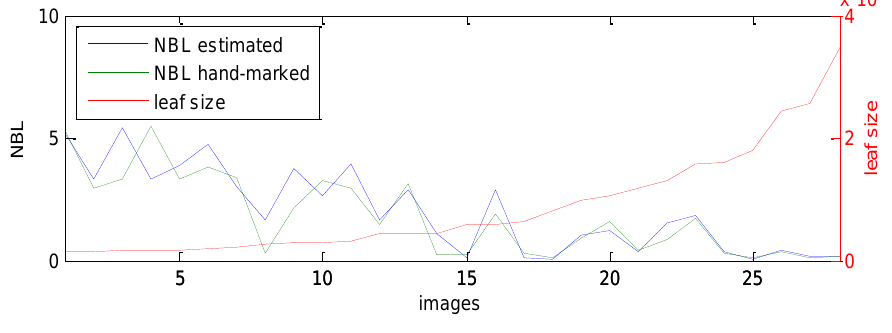
Figure 15. Number of brown leaves (NBL), for different images, estimated with our algorithm (solid line) and hand-marked (dashed line) for comparison. Images are sorted by the leaf size, also showed (dash-dotted line).